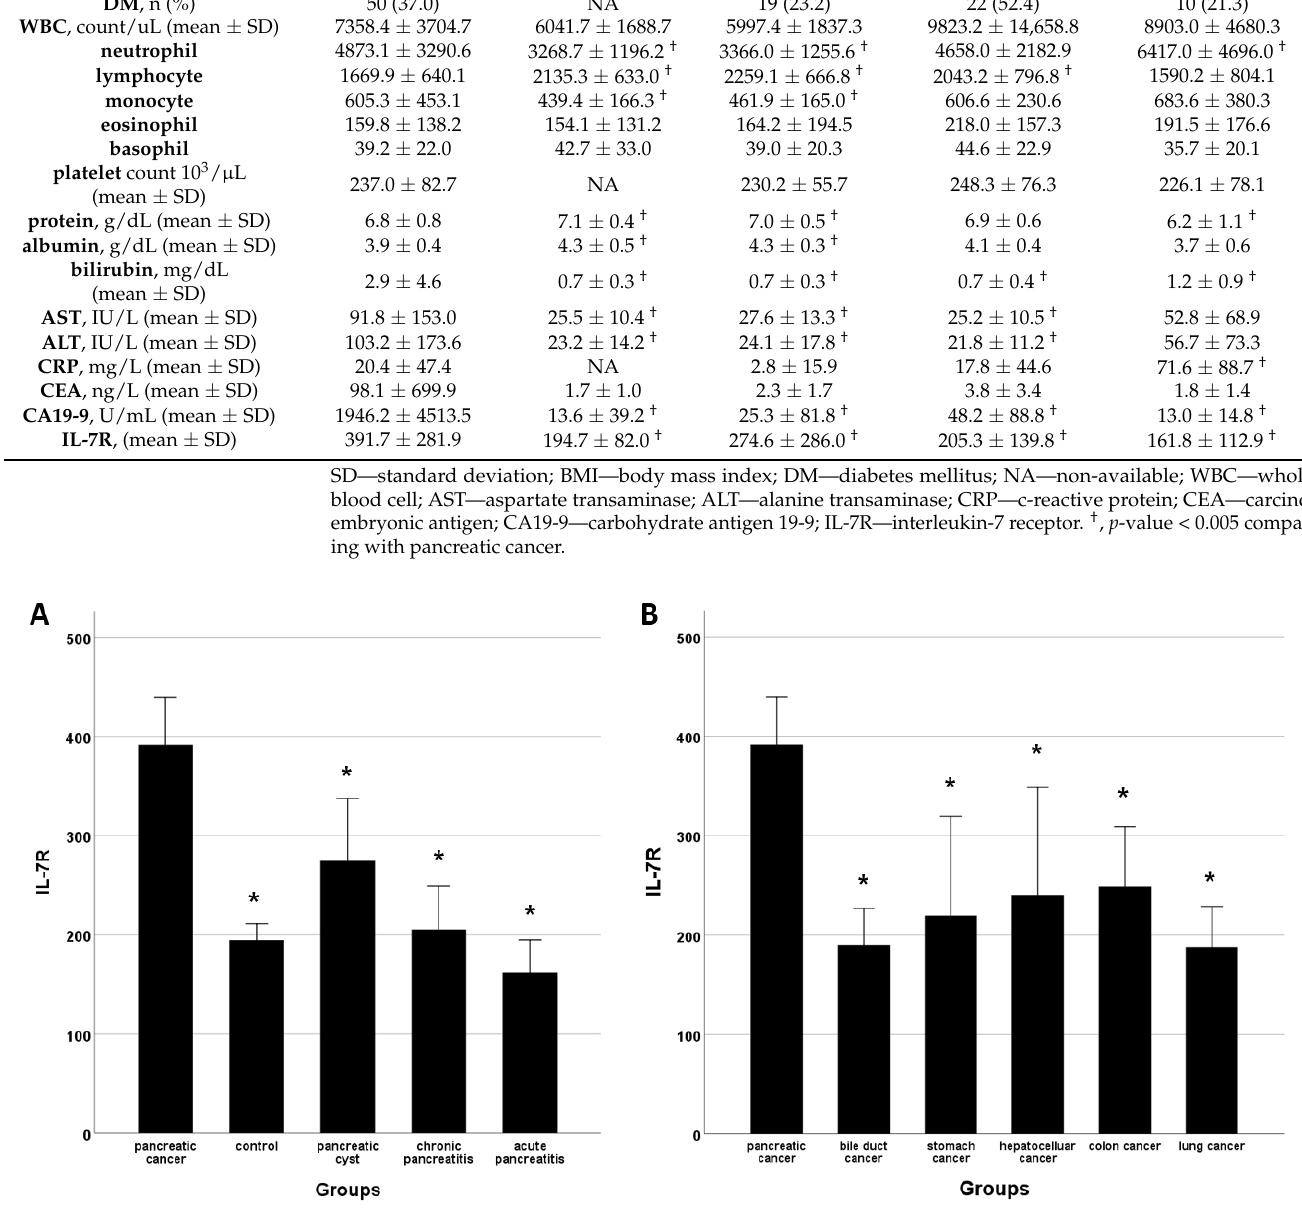
Figure 2. IL-7R levels. ( A ) IL-7R levels were significantly higher in patients with PDAC than in healthy controls and patients with pancreatic cysts, chronic pancreatitis, and acute pancreatitis. ( B ) Patients with PDAC had higher IL-7R levels than did those with systemic malignancies of the bile duct, stomach, liver, colon, or lung. * p < 0.005 vs. pancreatic